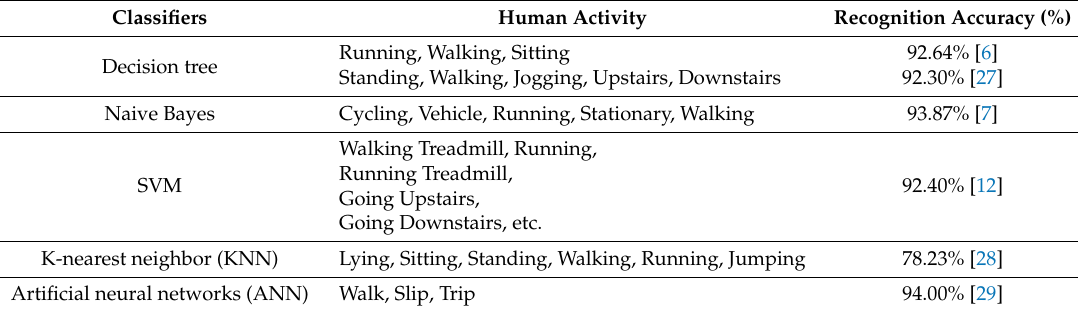
Table 2. Human activity recognition based on different supervised learning